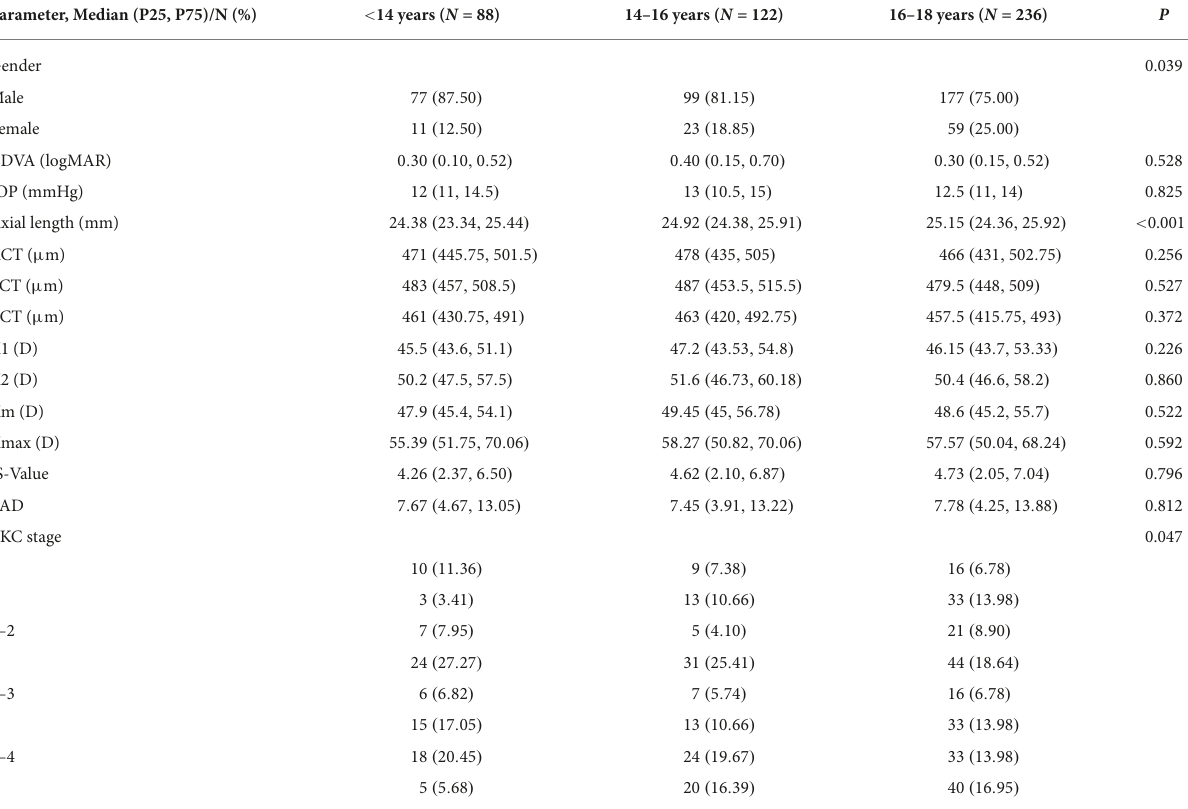
TABLE 3 Distribution of keratoconus by age groups.